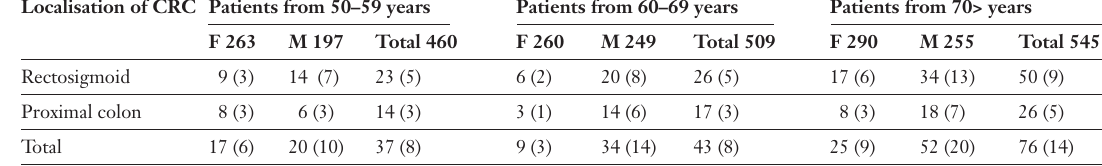
Distribution of colo- rectal cancer ac- cording to site and age (4 patients with 2 synchronous cancers included, number of cancers = 87, data given in raw num- bers and